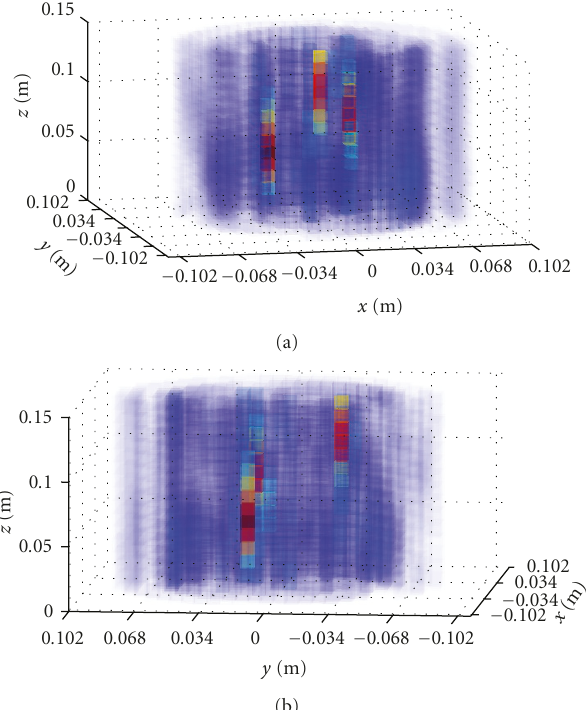
Figure 11: Experiment 3 reconstructed 3D image: (a) ( x , z ) plane view, and (b) ( y , z ) plane